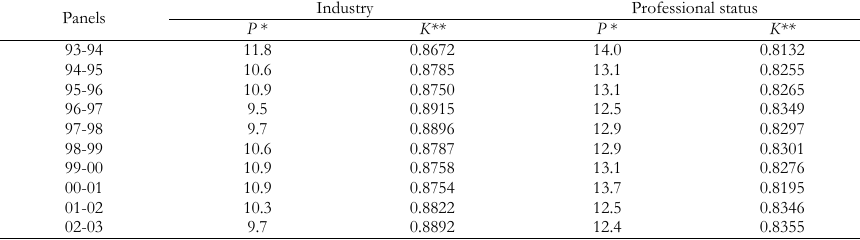
Measures of inconsistencies with reference to industry and professional status